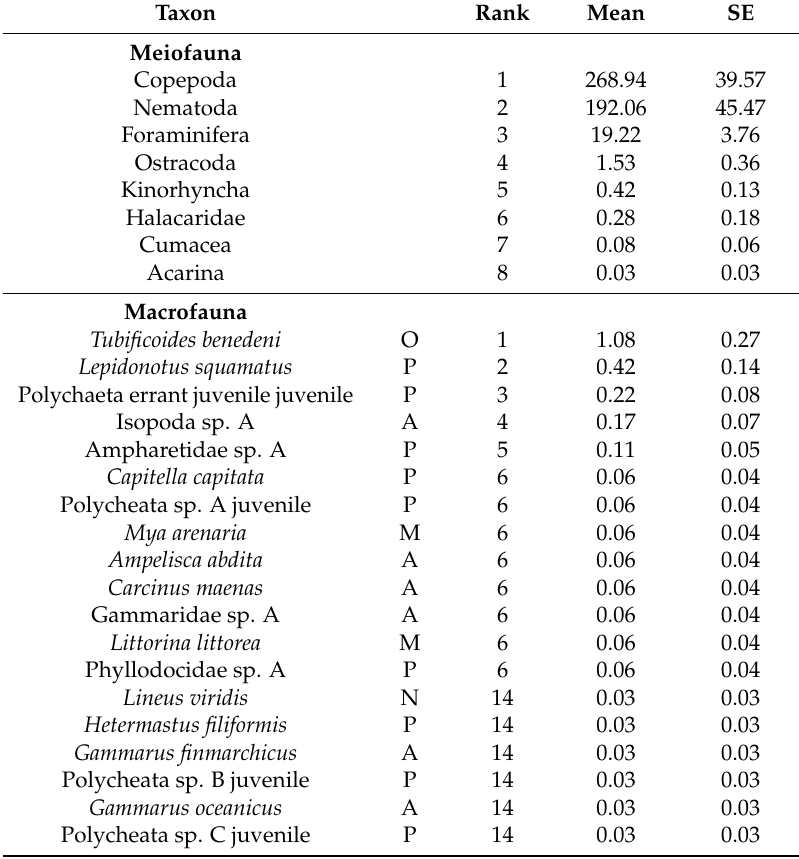
Table A1. Macrofauna and meiofauna captured in traps (overall mean + SE individuals per trap) by rank order. For macrofauna: A = Arthropoda, M = Mollusca, N = Nemertea, O = Oligocheata, P =